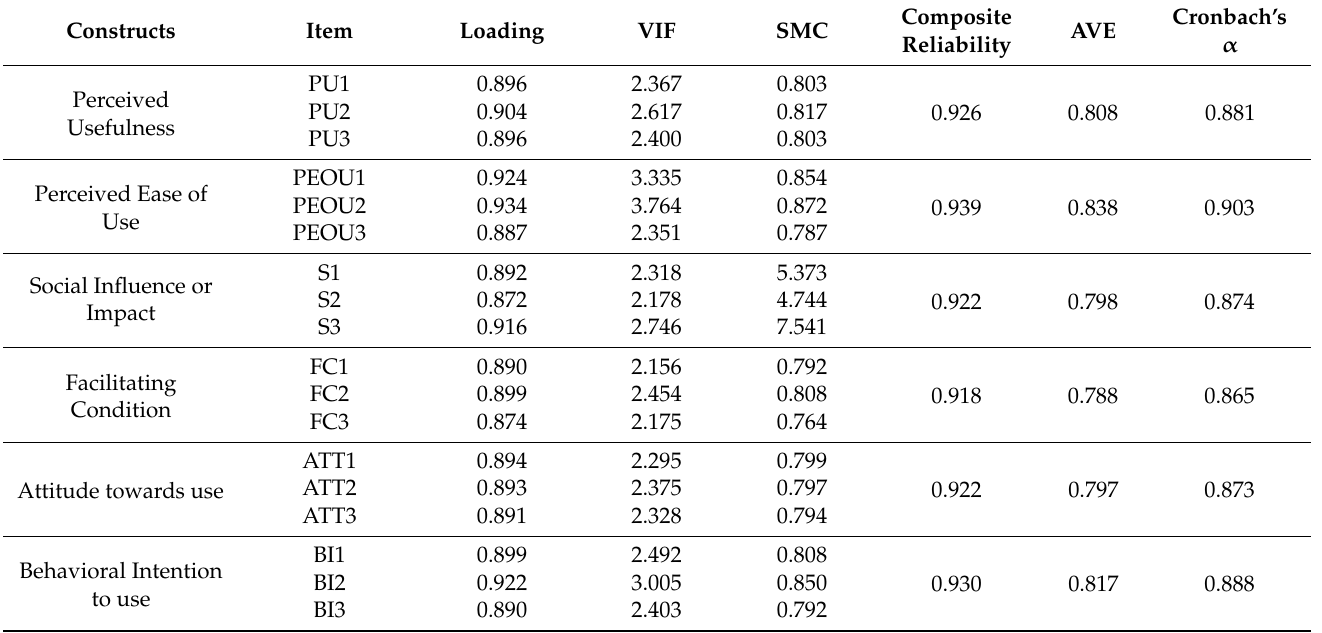
Table 3. Factor loading and Reliability Test.